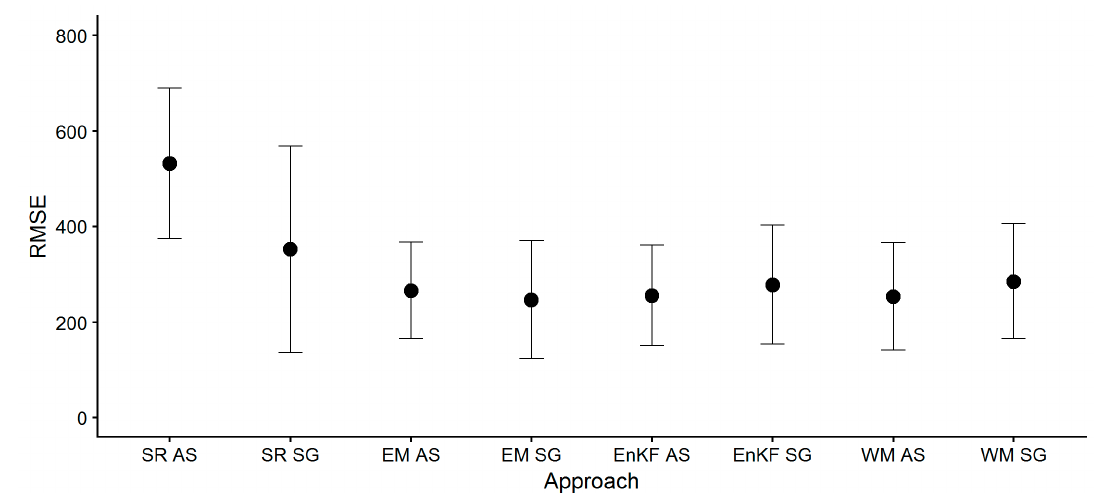
Figure 3. Mean and standard deviation of RMSE of total aboveground biomass for tested approaches.